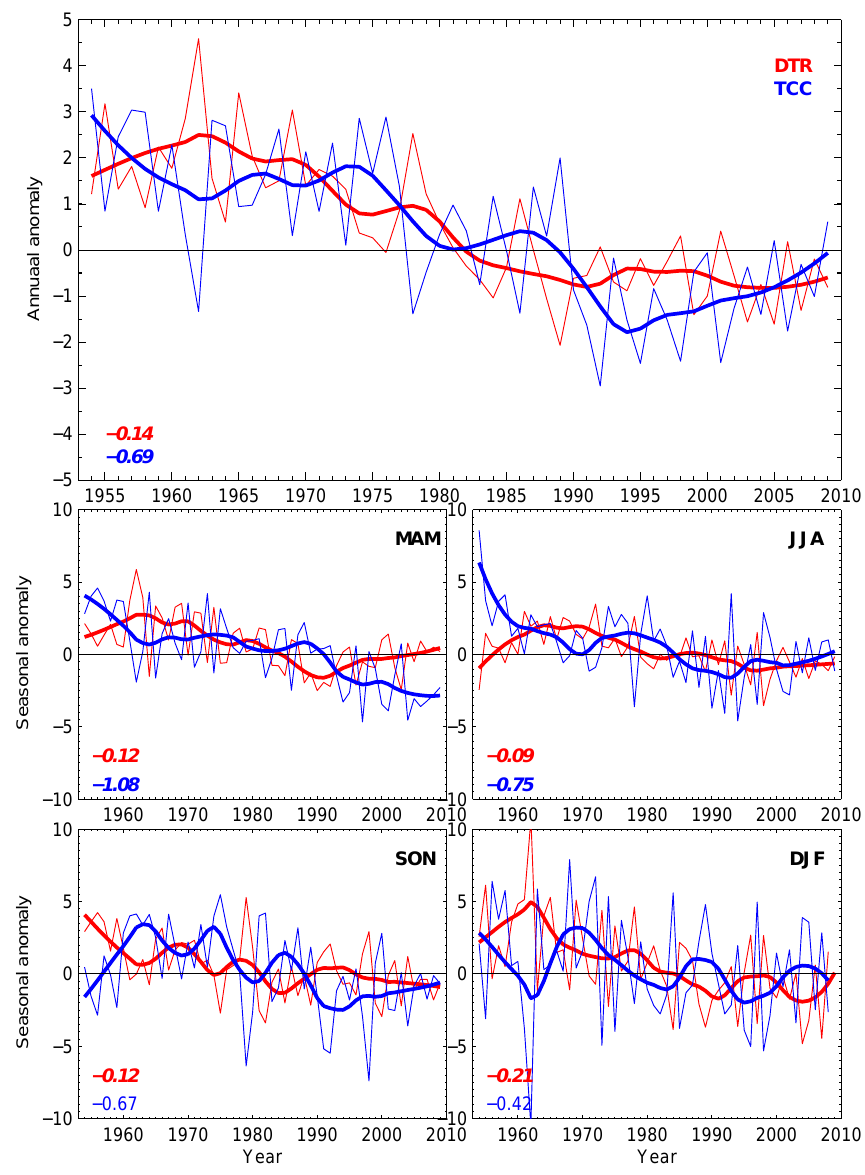
Fig. 3. Same as Fig. 2 but for the average China series.